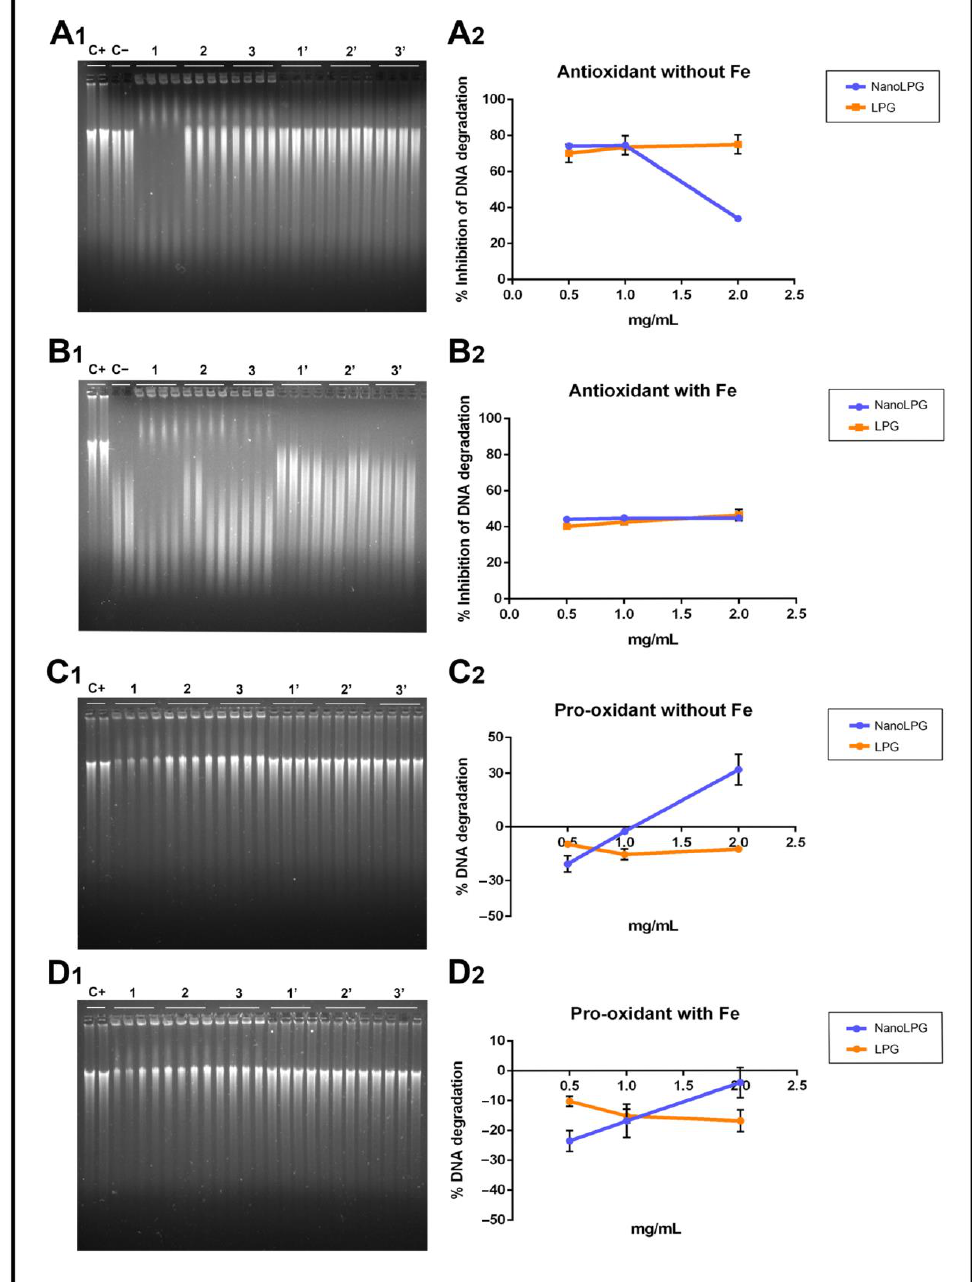
Figure 1. Electrophoresis results and the corresponding graphic of antioxidant activity in the pre- vention of DNA oxidation by H 2 O 2 ( A 1 , A 2 ) and H 2 O 2 /FeCl 3 ( B 1 , B 2 ) and the pro-oxidant effect in the absence ( C 1 , C 2 ) and presence ( D 1 , D 2 ) of iron cations of the different concentrations (0.5, 1 and 2 mg/mL ( v / v )) of nanoLPG and LPG). (C+) DNA solution; (C − ) DNA solution + degradation system; (1, 2 and 3) nanoLPG at 2, 1 and 0.5 mg/mL ( v / v ), respectively; (1 (cid:48) , 2 (cid:48) and 3 (cid:48) ) LPG at 2, 1 and 0.5 mg/mL ( v / v ), respectively. The data represent the mean ± SD from one